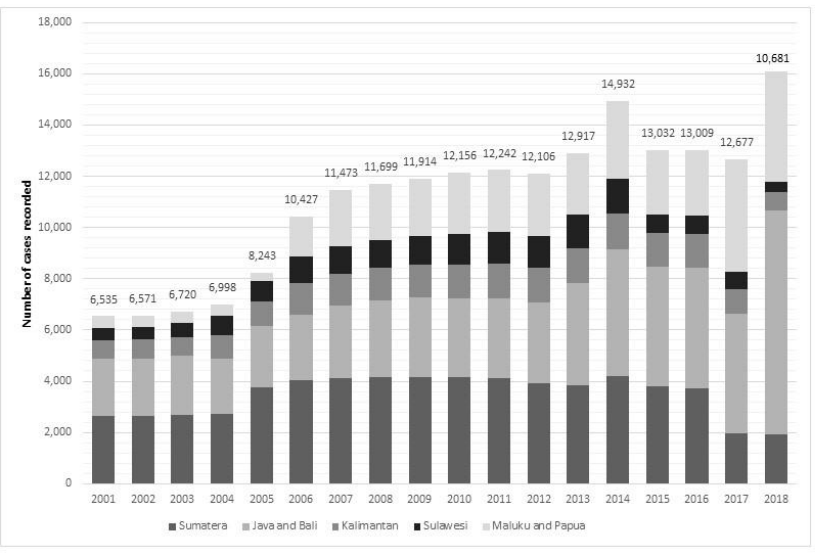
Figure 1. Number of Chronic Lymphatic Filariasis Cases in Indonesia 2001−2018.